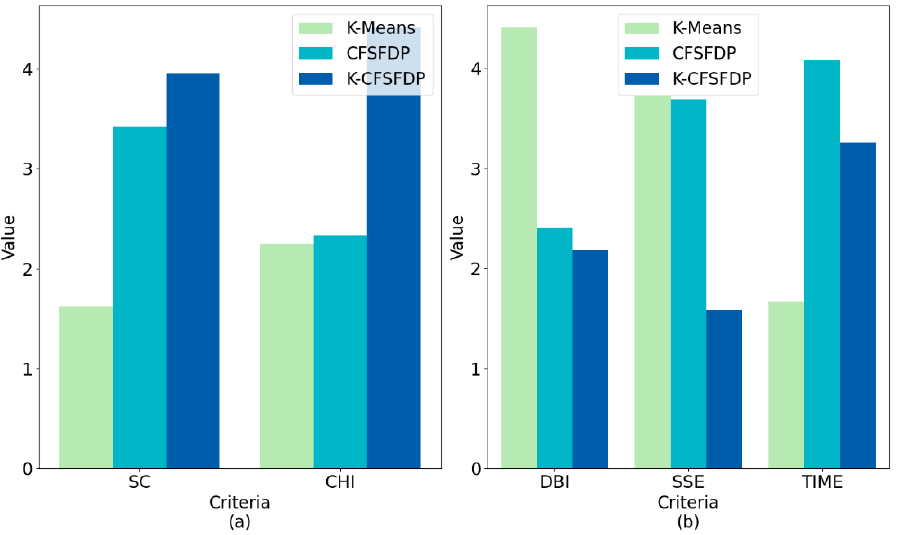
Figure 18. Clustering performances of three models under different evaluation criteria in dataset S3: ( a ) the higher the value, the better and ( b ) the lower the value, the better.